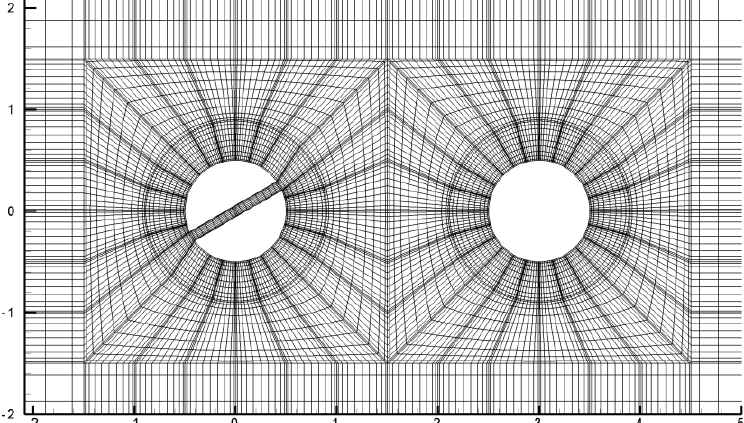
Figure 1. The closer view of the elements and grids with order of the Legendre polynomial, N = 11, of a two-cylinder tandem array with space ratio, L/D = 3, whose upstream cylinder has a slit at α = 30° and whose downstream cylinder is a regular one.